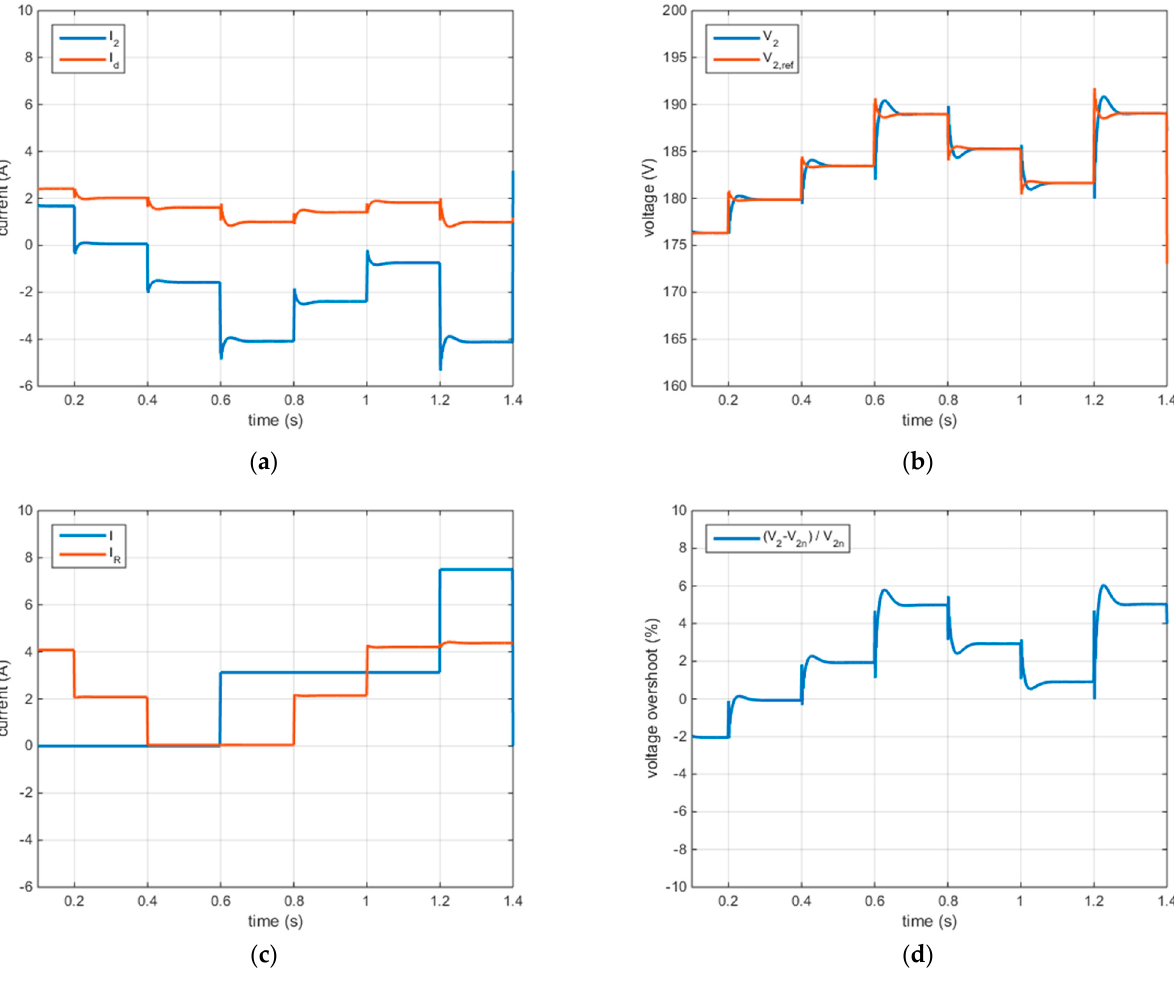
Figure 6. Performance obtained in scenario #3 (SD − GD): ( a ) output current and droop-controlled generator’s current; ( b ) actual and reference grid voltage; ( c ) external generator’s current and load current; ( d ) grid voltage overshoot.